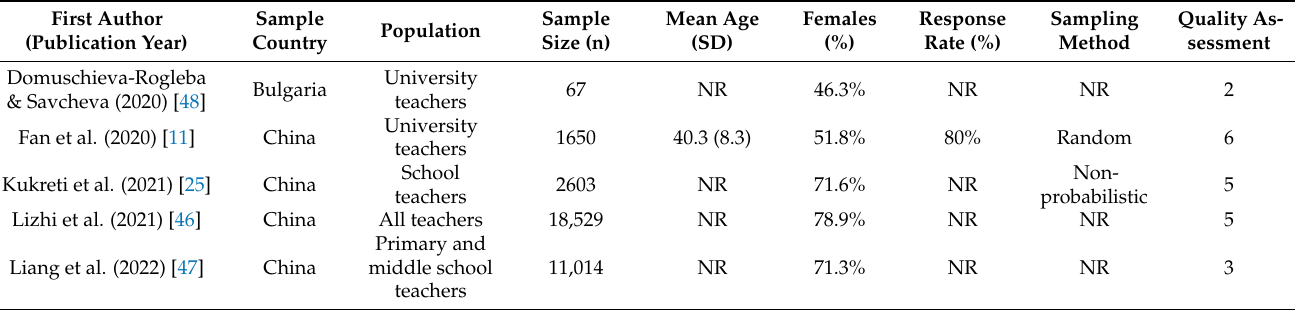
Table 1. Characteristics of the studies included in the